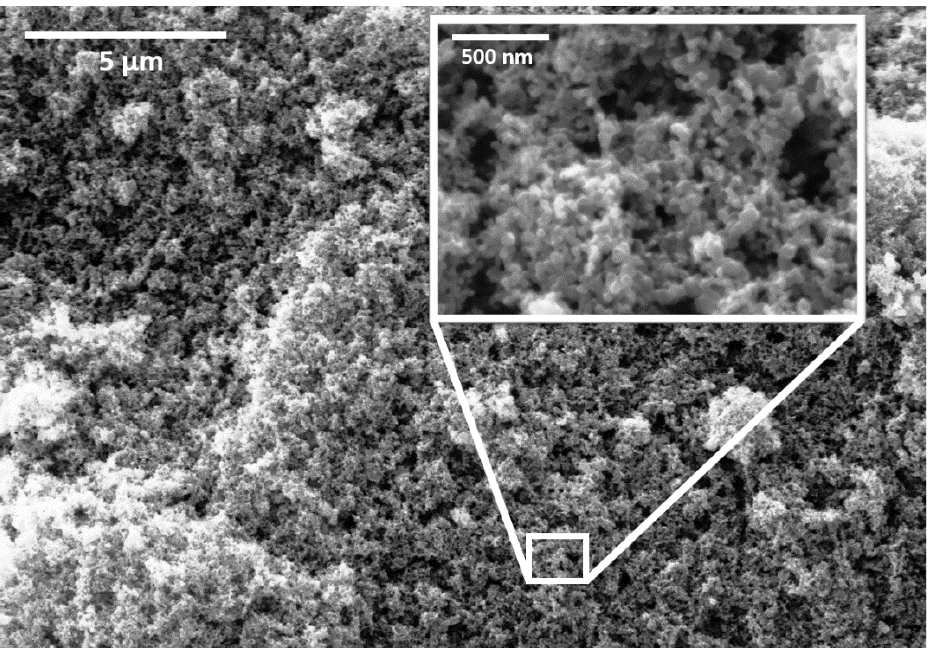
Figure 2. Surface of the superhydrophobic layer obtained by sputtering. Image acquired through a VEGA TESCAN 3 microscope.